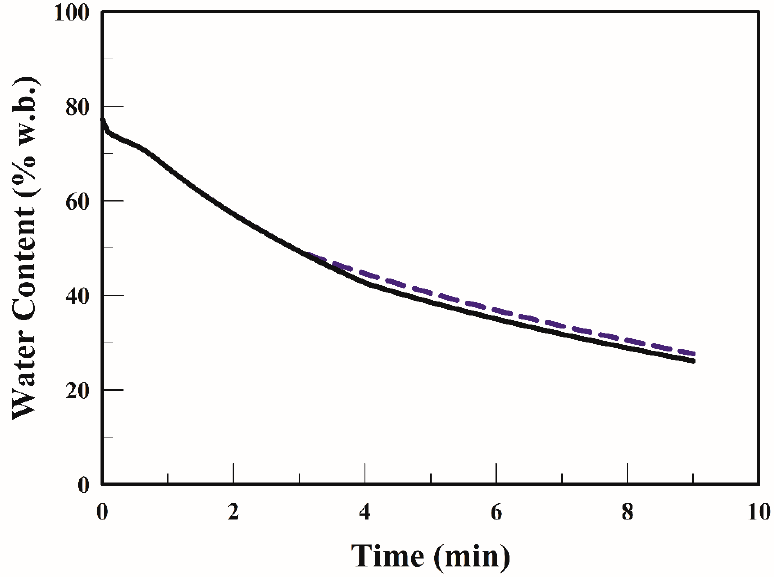
Figure 5. Profiles of the average water content in the strip when fried with the temperature-step frying approach at 170 °C for 3 min (dotted line) and for 4 min °C (solid line).